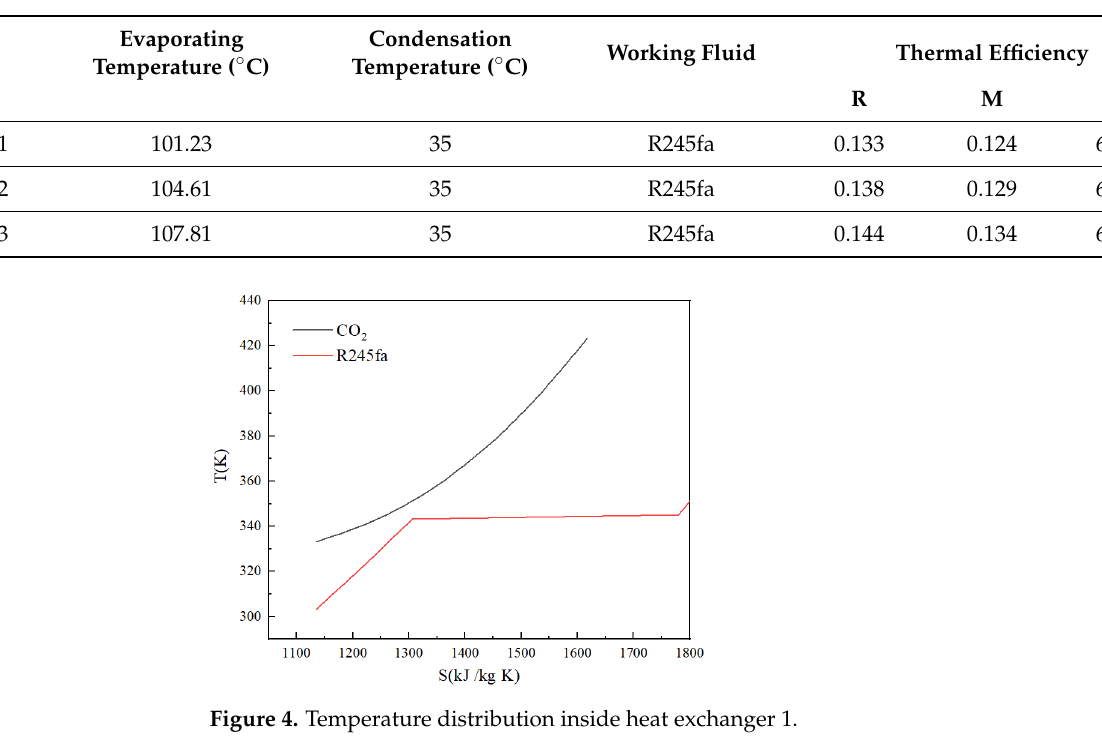
Table 5. Comparison of the calculated values of thermal efficiency of the ORC system obtained by system modeling with the corresponding values reported in the literature [40]. (R: reported; M: modeling; D: difference).